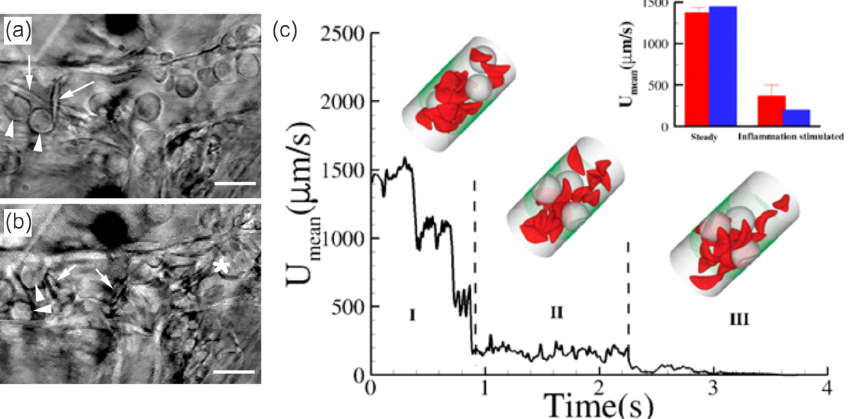
Figure 5. Still frames of intravital microscopy showing ( a ) interactions between SS-RBCs (arrows) and adherent leukocytes (arrow-heads) in the venules of sickle mice and subsequent ( b ) venular occlusion (white asterisk). Reproduced from reference [112]. ( c ) In silico studies of vessel occlusion induced by inflammation-stimulated leukocytes. Instantaneous mean velocity of the blood flow in a vessel of diameter of D = 20.4 µ m and Hct = 13% encompassing three leukocytes. (Insets) The green dotted region represents the coated ligands, mimicking the inflammation region of the vessel. Snapshots represent blood flow states as follows: (I) initial stage of inflammatory response and free motion of the blood flow; (II) moderate RBC-leukocyte interactions and blood flow slowdown; (III) late stage of the inflammatory response, where the RBC-leukocyte interaction is further intensified, leading to entrapment of multiple SS-RBCs on the adherent leukocytes and consequent vessel occlusion. (Inset plot) Side-by-side comparison of experiments versus simulations. The blue bars represent the blood flow velocity of the present study and the red bars represent the experimental results in reference [100], where measurements were taken on 23–41 venules with average diameters of 20.9 ± 1.3 µ m and 24.9 ± 1.8 µ m before and after inflammation stimulation. Reproduced from Lei et al.